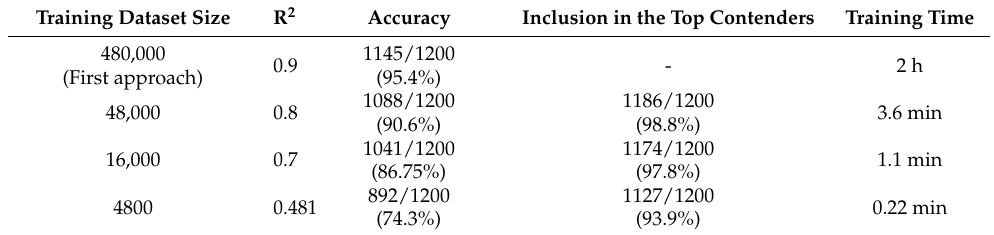
Table 3. Comparison between the networks using different dataset